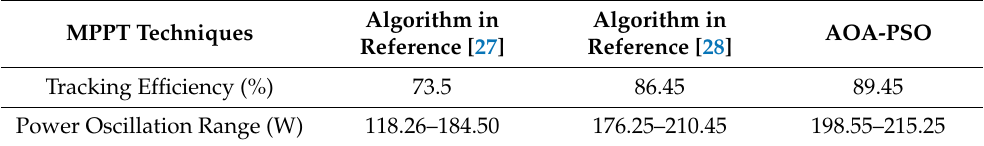
Table 5. Comparison of the experimental results of different